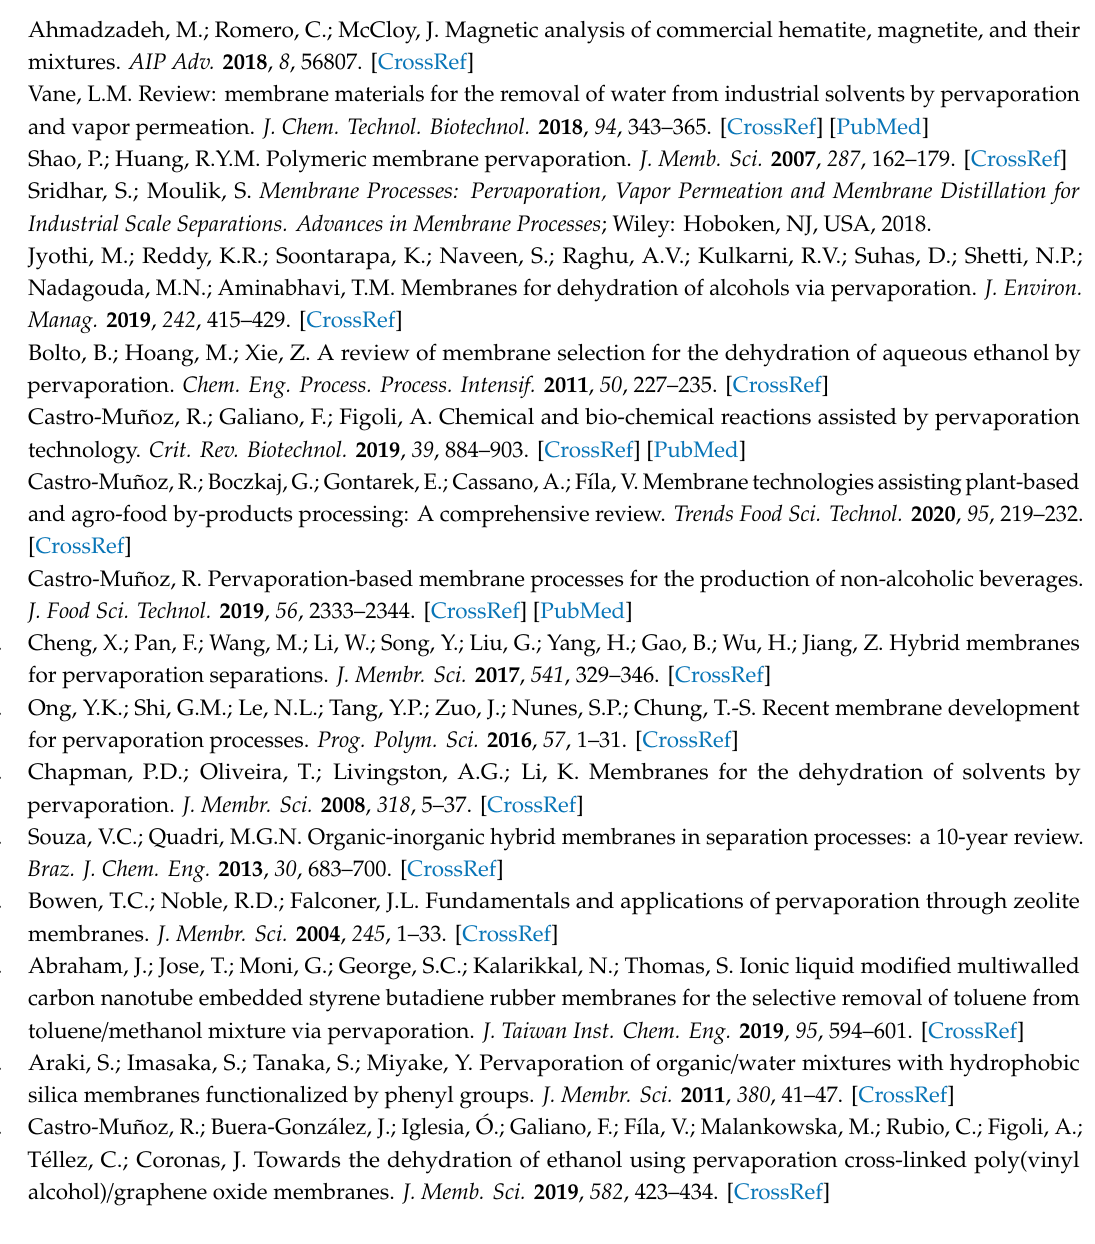
symbols) di ff usion coe ffi cients with increasing content of hematite, magnetite and iron(III) acetylacetonate fillers in PVA membranes, Figure S5: The variation of water (full symbols) and ethanol (blank symbols) solubility coe ffi cients with increasing content of hematite, magnetite and iron(III) acetylacetonate fillers in PVA membranes, Figure S6: The variation of water (full symbols) and ethanol (blank symbols) permeation coe ffi cients with increasing content of hematite, magnetite and iron(III) acetylacetonate fillers in PVA